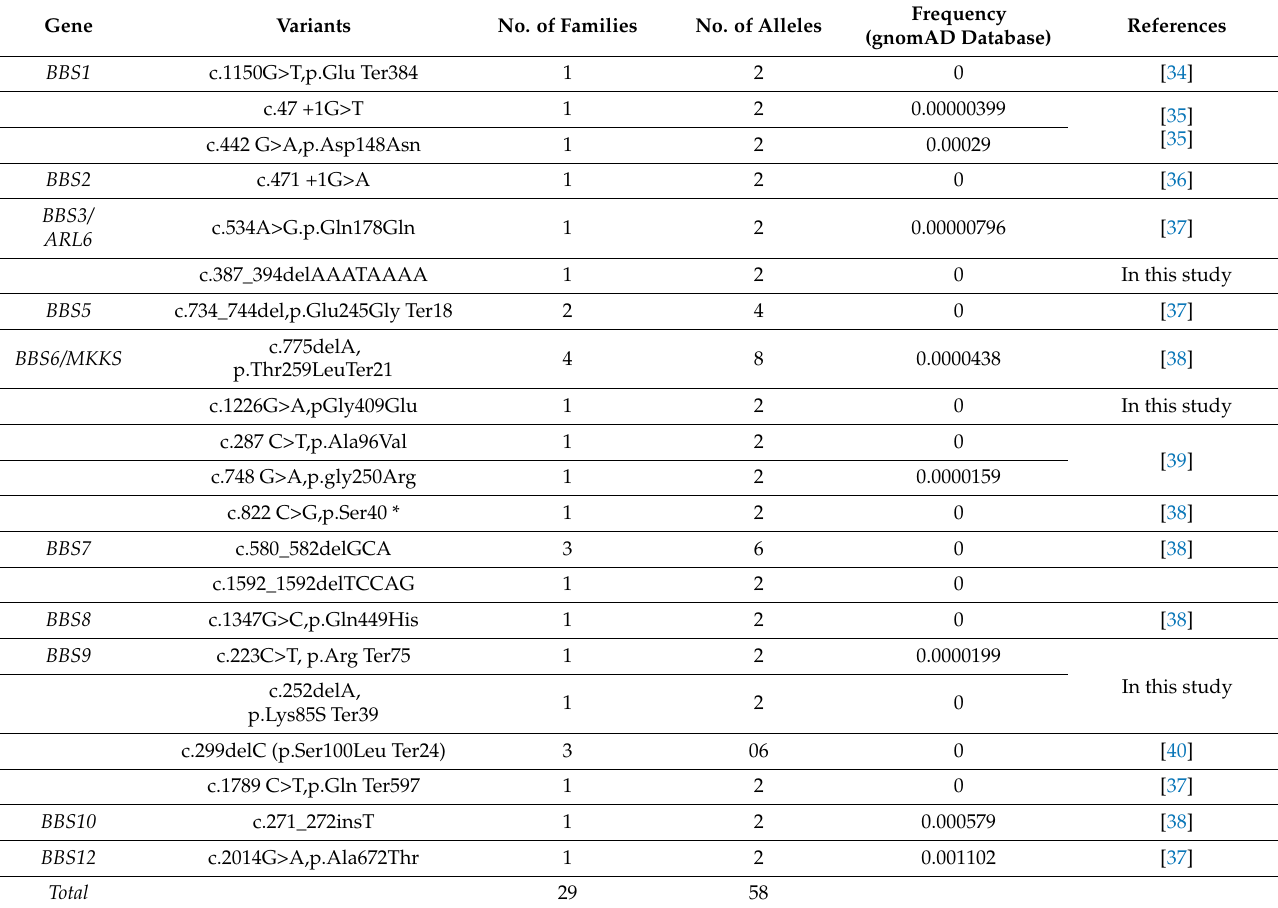
Table 2. BBS associated variants detected in Pakistani